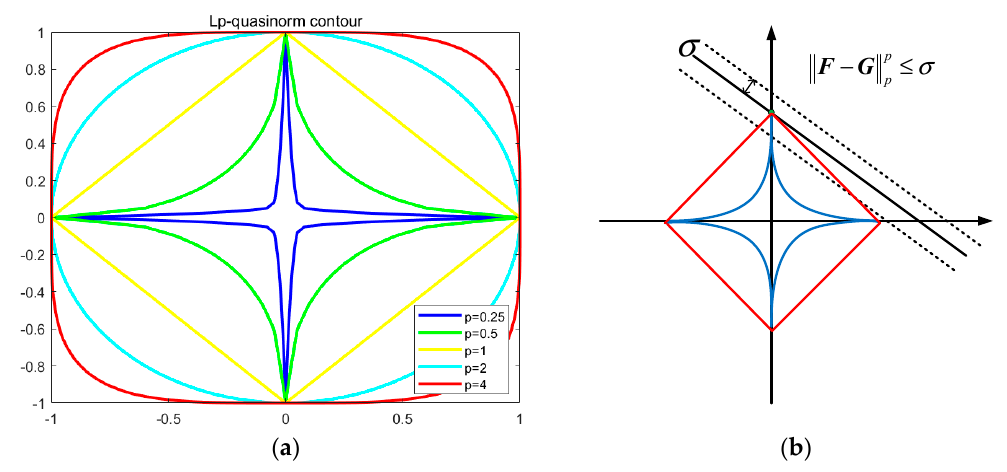
Figure 1. Schematic diagram of feasible domains for various norms. ( a ) Lp-quasinorm contour: p takes values of 0.25, 0.5, 1, 2, and 4 from inner to outer contour lines; ( b ) Feasible domains for 0 < p < 1 ( blue ) and p = 1 ( red